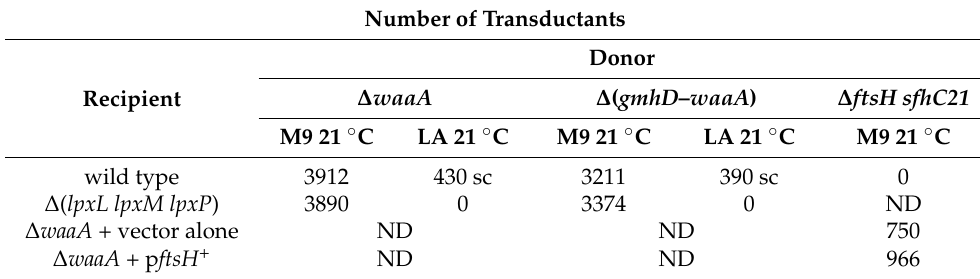
Table 2. Determination of the viability of ∆ waaA derivatives in the wild type, ∆ ( lpxL lpxM lpxP ) and ∆ ftsH strains by bacteriophage-mediated transductions. ND: not determined; sc: small colonies. Numbers indicate the number of transductants using an equivalent amount of